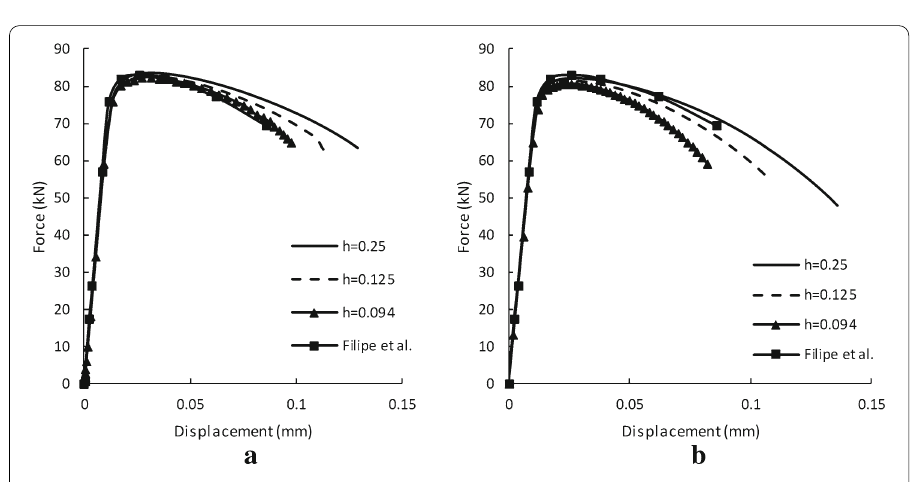
Fig. 6 Force variation with the applied displacement for a the local model and b the nonlocal model